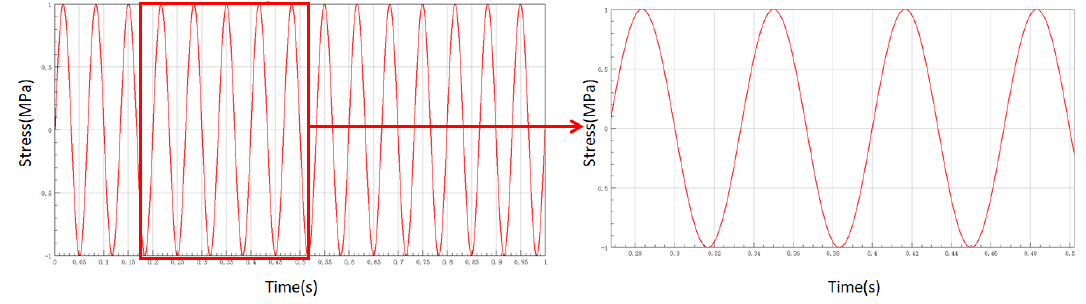
Figure 4. Fatigue life analysis load spectrum.